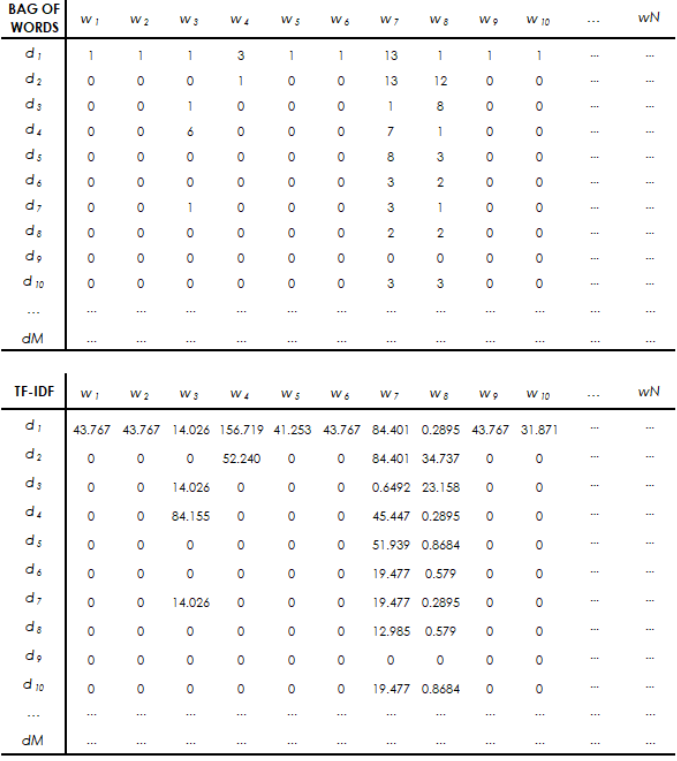
Figure 5. The effects of the tf-idf correction on A ( d 1:10 , w 1:10 )